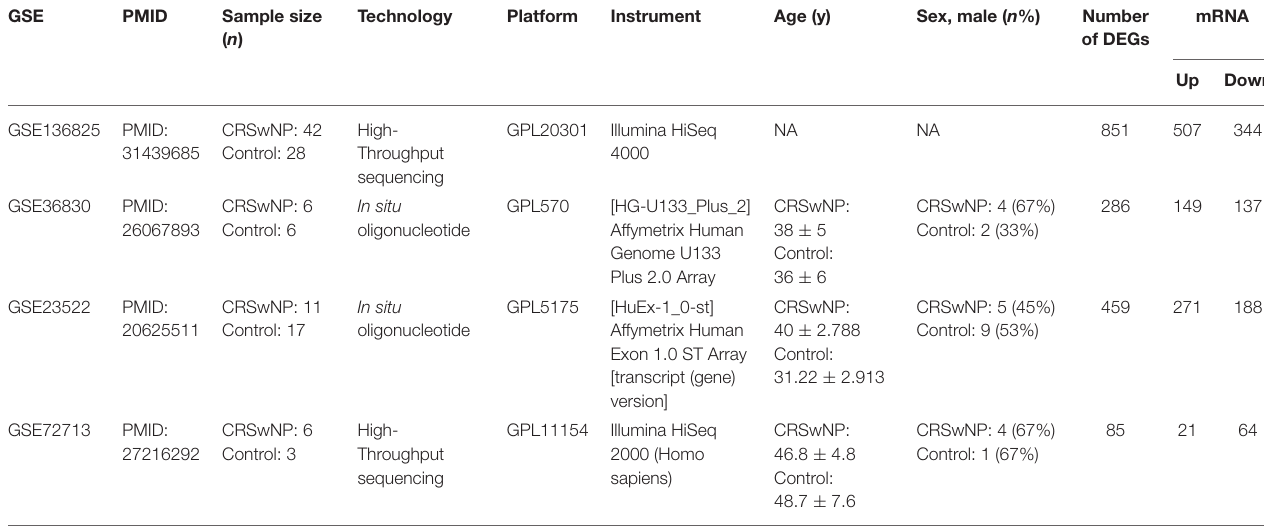
TABLE 1 | The details of GEO datasets for CRSwNP.